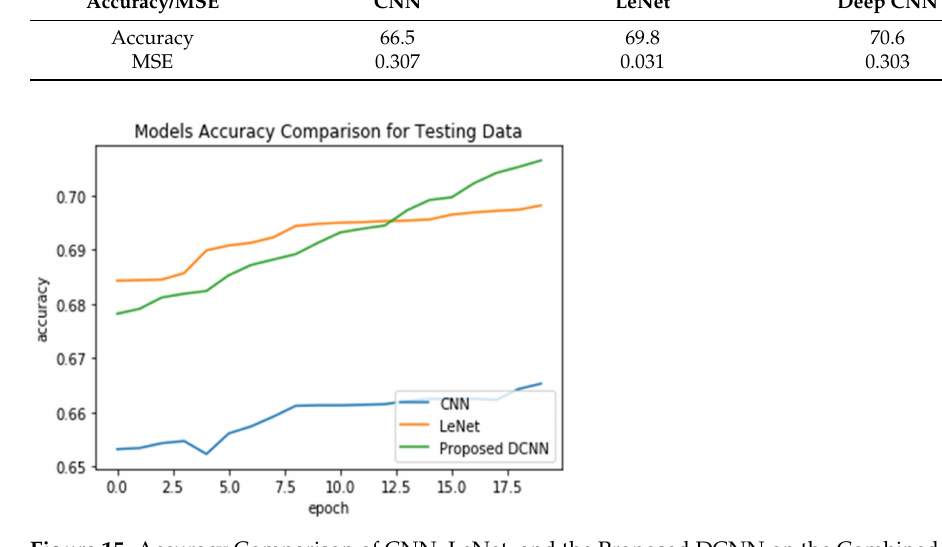
Figure 15. Accuracy Comparison of CNN, LeNet, and the Proposed DCNN on the Combined Pashto Digit and Character